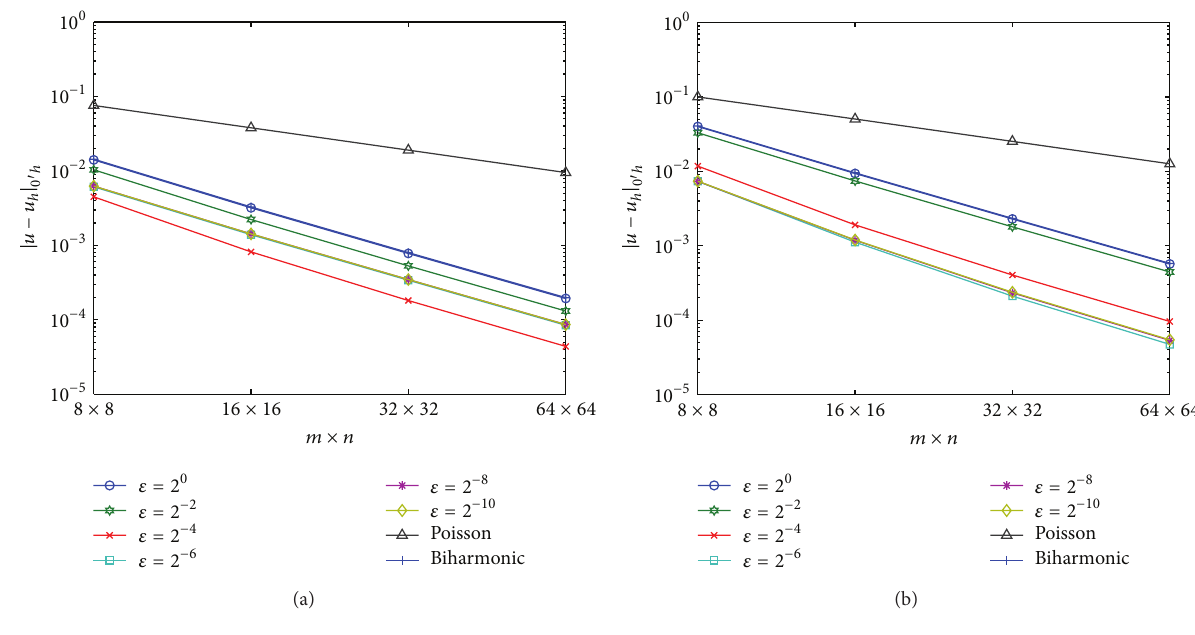
Figure 7: The error |𝑢 − 𝑢 ℎ | 0 under mesh 1 (a) and mesh 2 (b). Table 2: The errors |‖𝑢 − 𝑢 ℎ ‖| 𝜀,ℎ /|‖𝑢‖| 𝜀,ℎ employing approximation form (14) under mesh 1. 𝜀 \ 𝑚 × 𝑛